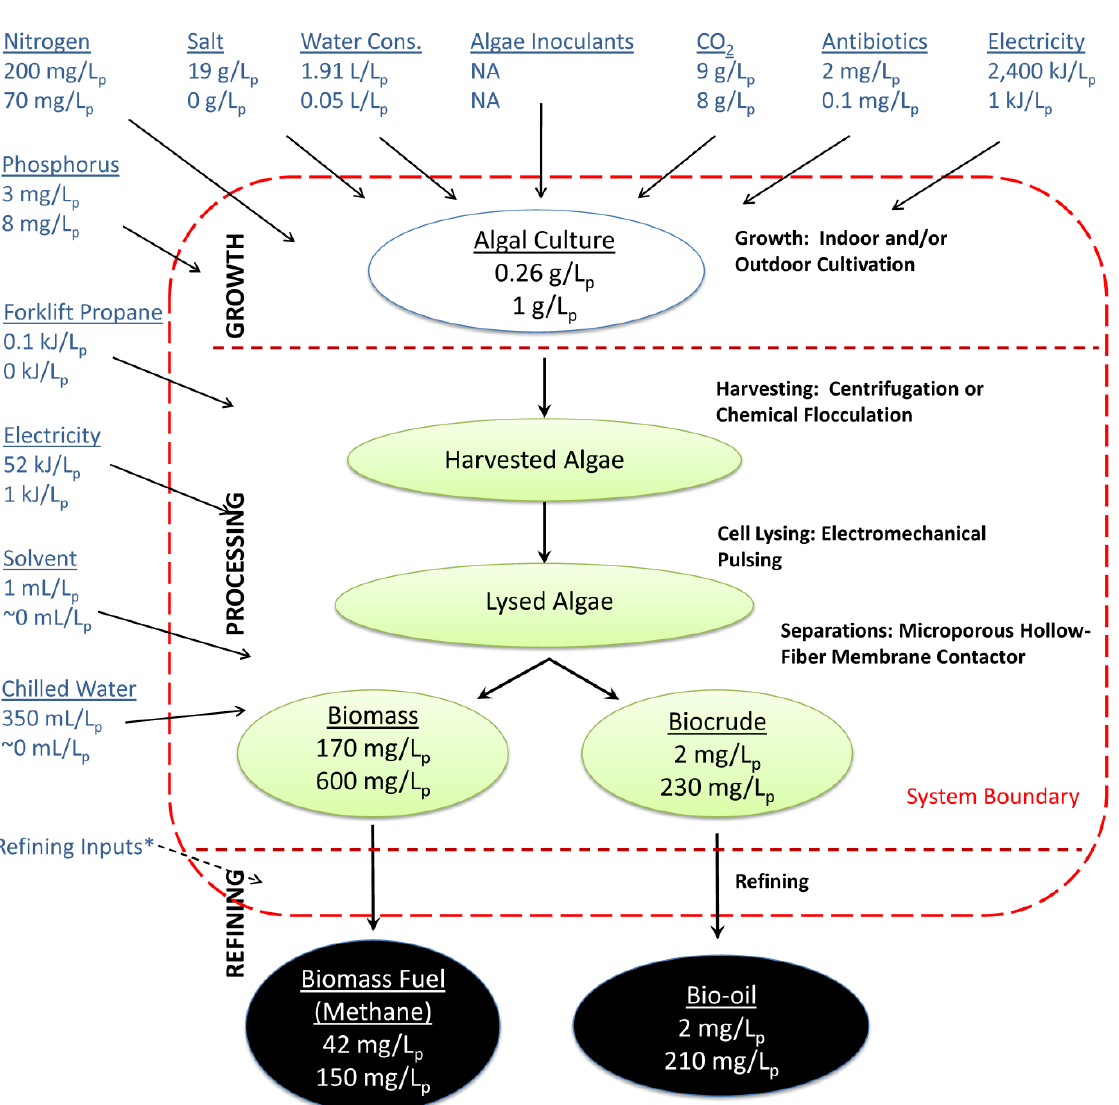
Figure 1. The production pathway is represented as three phases: growth, processing, and refining [6]. The data used for each input and output are shown for the Experimental Case (top) and Highly Productive Case (bottom). For the Experimental Case , the material and energy inputs crossing the system boundary were measured for five relatively large scale batches (970–2000 L, each), grown and processed at The University of Texas at Austin, except for the refining inputs (which were modeled from literature data, and are noted in the figure with an asterisk (*) [14]. The Highly Productive Case is an analytical model of a similar production pathway operated more